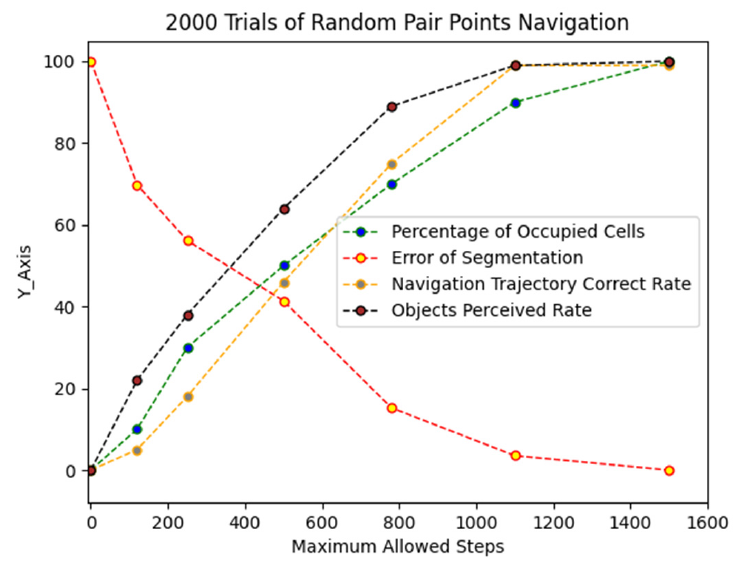
Figure 9. 2000 trails of random pair points experiment.